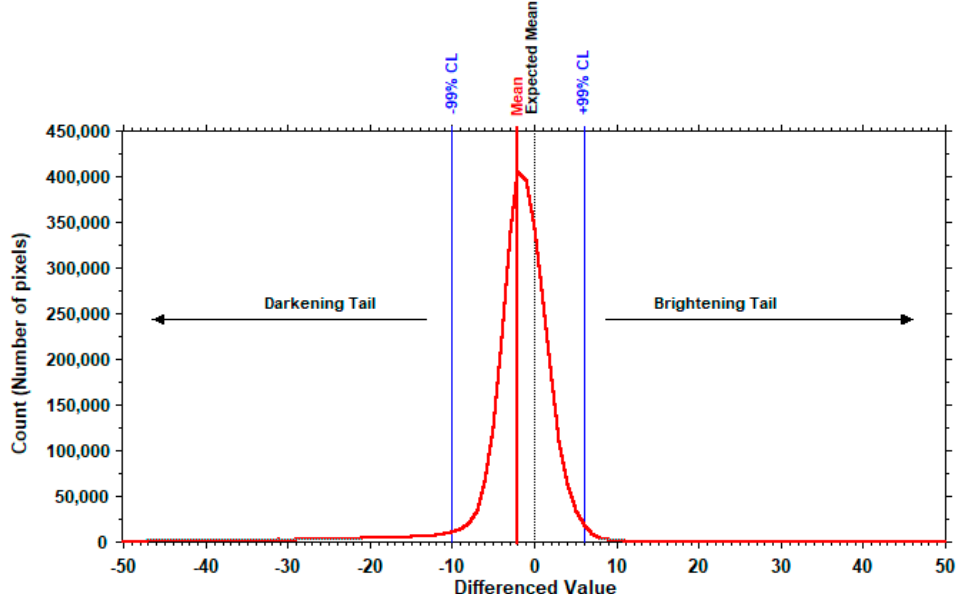
Figure 6. Difference value distribution for the University Peak subarea. Distribution of ~2.7-million- pixel values. Darkening/brightening tail implies that individual pixels had a lower/higher Digital Number (DN) value in successive images. The expected difference of 0.0 (equal random brightening and darkening) differs from the population mean of all pixels of ~ − 4.0. This is primarily due to the impact of exposure of darker rock because of snowfield melt off. Shadowing differences between image pairs were responsible for both brightening and darkening in approximately equal propor- tions.